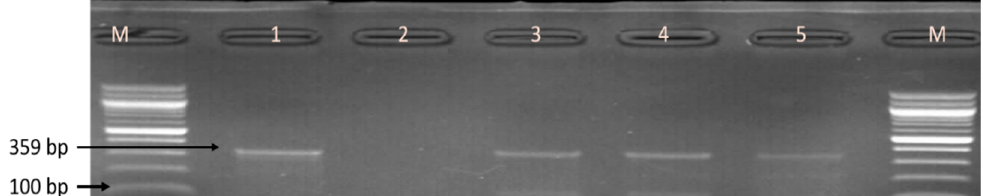
Figure 4. Gel picture of some PCR-identified C. fetus . Lane M: molecular weight marker (100 bp); lane 1: positive control ( C. fetus ATCC 27374); lane 2: negative control; lanes 3–5: positive C. fetus isolates (359 bp).